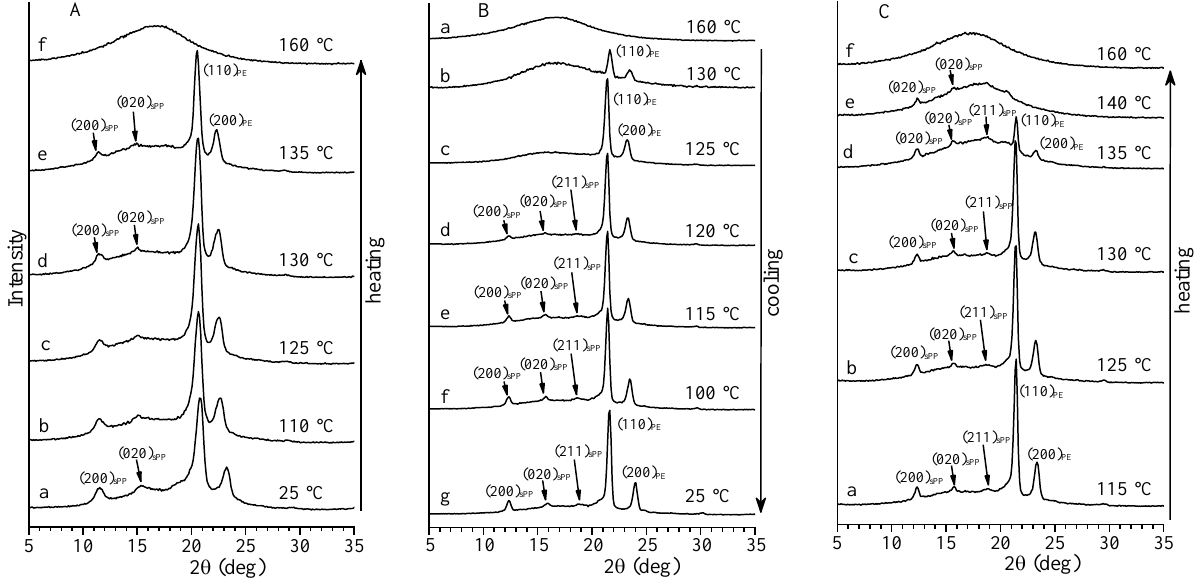
Figure 3. X-ray powder diffraction profiles of the sample PE- b -sPP-1 with f sPP = 53% recorded at different temperatures during first heating (a-f) of the as-prepared sample up to the melt ( A ), during cooling (a-g) from the melt down to room temperature ( B ), and during successive heating (a-f) of the melt-crystallized sample up to the melt ( C ). The (200) sPP , (020) sPP and (211) sPP reflections of form I of sPP at 2 θ = 12°, 16° and 18.8°, respectively, and the (110) PE and (200) PE reflections of the orthorhombic form of PE at 2 θ = 21° and 24°, respectively, are indicated.